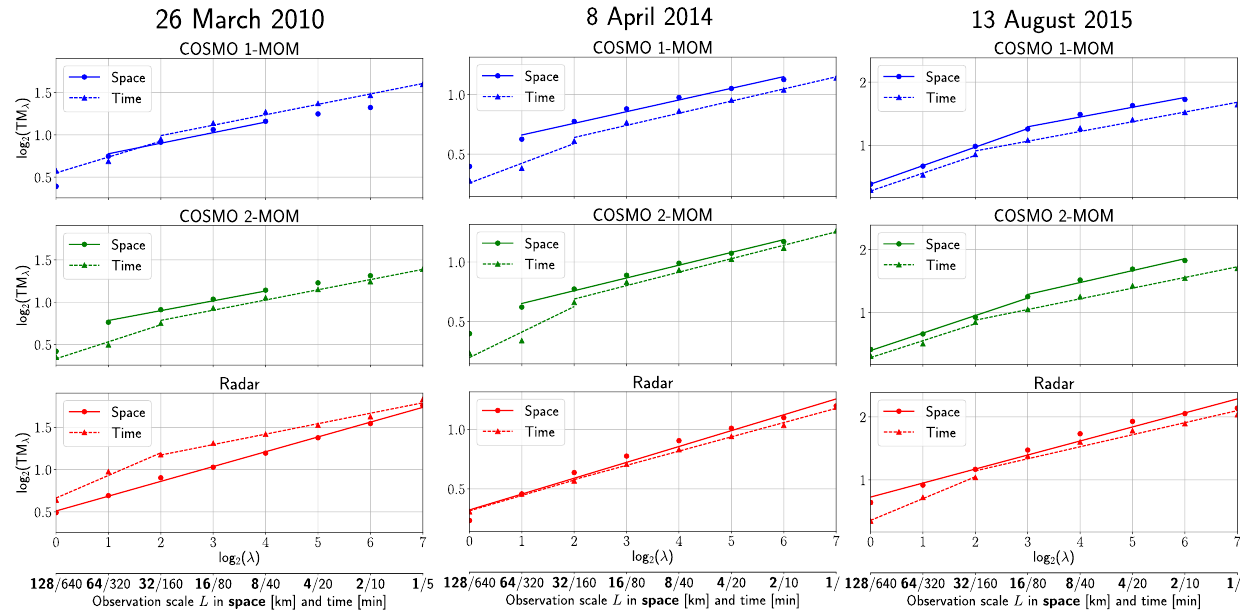
Figure 8. Scaling (TM) analysis of the QPE product during the three events obtained with q = 1 . 5. The displayed lines are best-fit lines that take into account a possible scaling